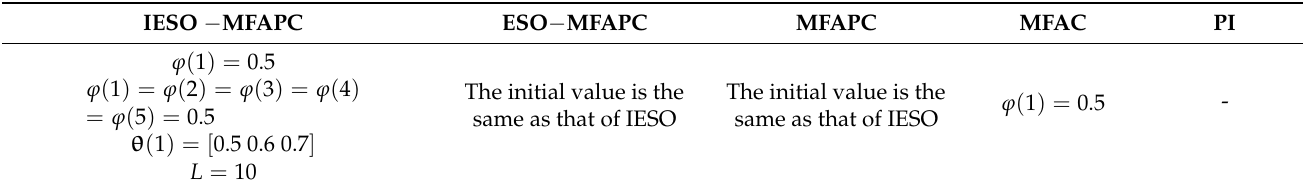
Table 3. Initial parameter values for the four control